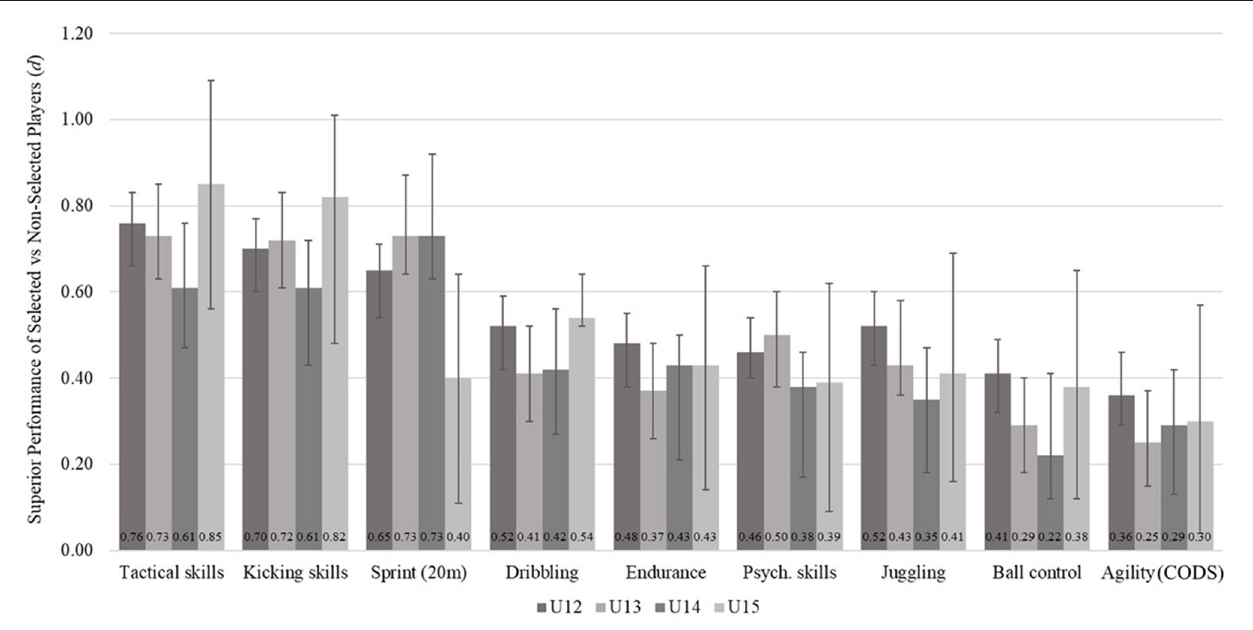
FIGURE 1 | Superior performance of selected vs. non-selected players in terms of Cohen’s d and respective 95% CI (the variables are ordered regarding the median of the effect sizes for the four age